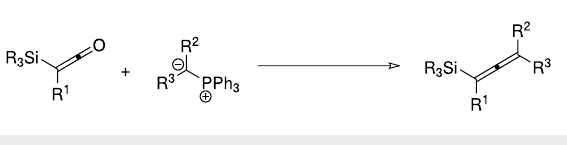
This convergent approach potentially allows for tremendous variation in substitution pattern at both termini of the allenylsilane, yet has been little exploited thus far. Ruden first demonstrated that the stabilised phosphorane carbethoxy- methylenetriphenylphosphorane underwent Wittig condensa- tion with trimethylsilylketene at sub-ambient temperature in high yield, but found that non-stabilised phosphoranes led to complex mixtures of products.[15] Other workers later extended this chemistry to include a wider range of stabilised phosphoranes, but attempts to promote the reaction with semi- stabilised ylides such as benzylidenetriphenylphosphorane were unsuccessful unless bis(trialkylsilyl)ketenes were used as substrates.[16,17] Thus, only 3-substituted and 3,3-disubsti- tuted allenylsilanes have thus far been accessed by alkylidena- tion of silylketenes, whilst no reports of the successful introduc- tion of non-stabilised ylide equivalents have been forthcoming. A second impediment to the generalisation of the approach has been the paucity of methods for preparing substituted silylketenes.[18,19] Methods based upon the thermolysis of siloxyalkynes [20] and dehydrohalogenation of substituted α-silyl acid halides [21,22] have not found general